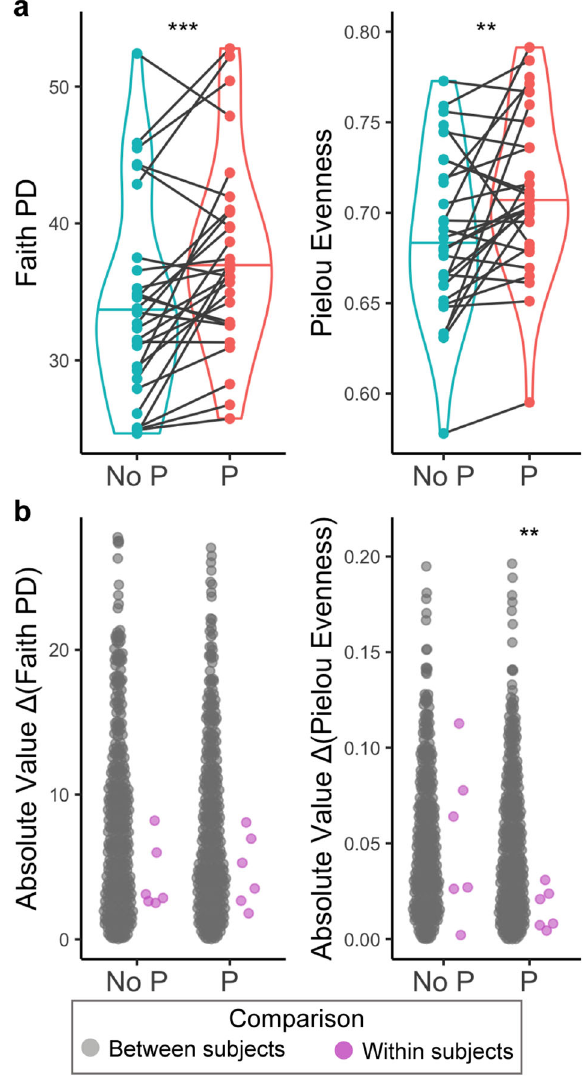
Fig. 4 Alpha diversity of samples, by collection method and over time. a Alpha diversity measures based on Faith PD and Pielou evenness by sample collection with preservative (P) or not (No P). Lines connecting points indicate sample pairs. ** p < 0.01, *** p < 0.001; linear mixed effects model. Center line on plots indicates median. b Absolute value of the differences in alpha diversity between all unrelated subjects (pink circles), and longitudinal samples within the same subject (gray circles). * p < 0.05, ** p < 0.01 ; Kruskal – Wallis but none have been tested on samples containing DNA preservatives. To reduce the amount of human DNA present in shotgun sequencing, we examined human DNA depletion in a subset of fi ve subjects, three of whom had samples on both day 1 and day 2, for a total of eight samples. Only those sample collected with preservative were sequenced (Fig. 1). Human DNA was depleted using the lysis propidium monoazide (lyPMA) technique 19 prior to DNA extraction and compared to DNA extracted with standard procedures. Samples from one of the subjects (with samples on Day 1 and Day 2) had very low DNA concentrations in both DNA extractions and the human DNA depletion treatment DNA concentration was insuf fi cient for sequencing. The standard extraction samples for this subject were sequenced and included in the analyses when paired tests